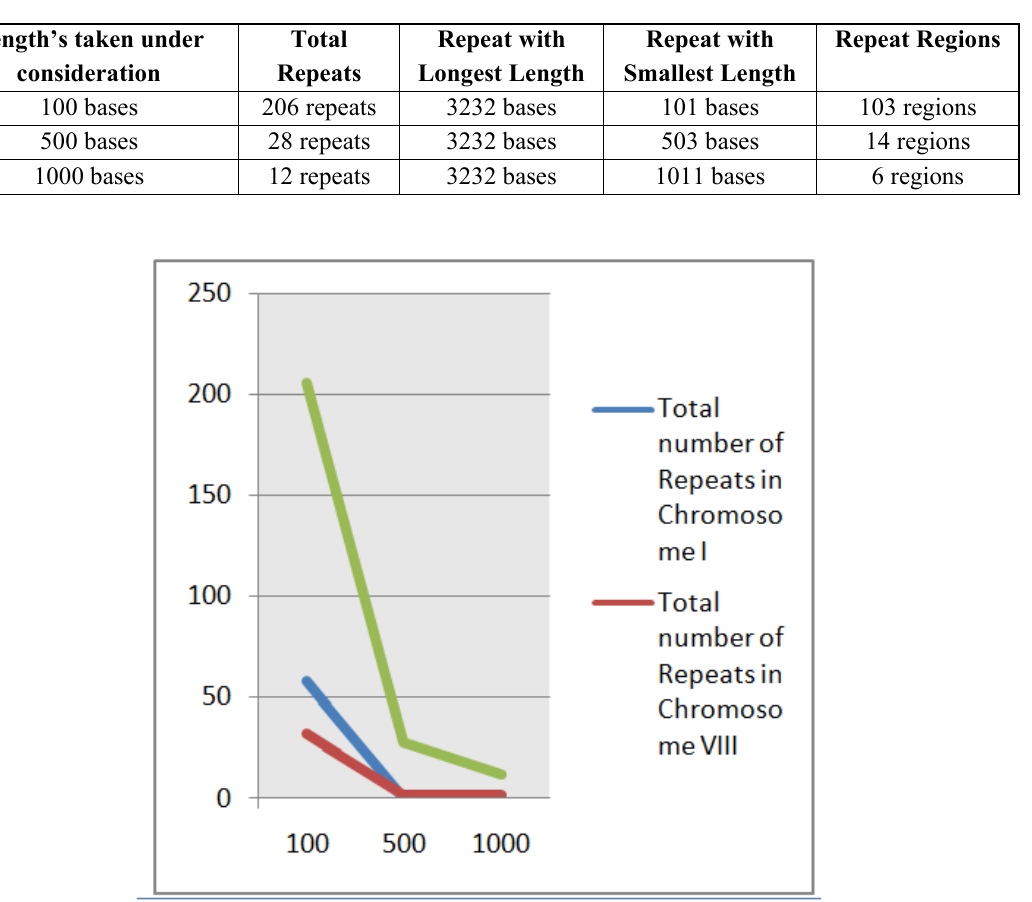
Figure 5. Enhancement in the Amount of Repeats when Searching or Self- and Cross-Chromosomal Similarities.